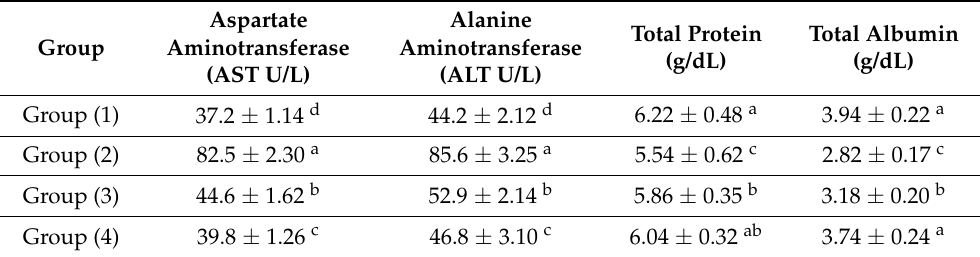
Table 6. Effect of fermented camel milk containing pumpkin seed milk on liver function parameters in experimental rats. Aspartate Alanine Total Protein Total Albumin Group Aminotransferase Aminotransferase (g/dL) (g/dL) (AST U/L) (ALT U/L) Group (1) 37.2 ± 1.14 d 44.2 ± 2.12 d 6.22 ± 0.48 a 3.94 ± 0.22 a Group (2) 82.5 ± 2.30 a 85.6 ± 3.25 a 5.54 ± 0.62 c 2.82 ± 0.17 c Group (3) 44.6 ± 1.62 b 52.9 ± 2.14 b 5.86 ± 0.35 b 3.18 ± 0.20